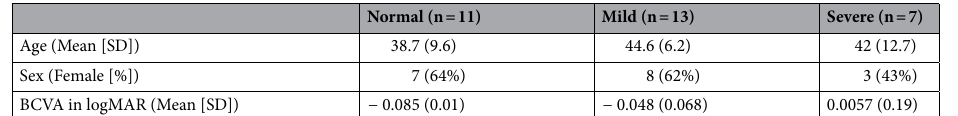
BCVA in logMAR (Mean Table 1. Demographic characteristics and BCVA across all participants. BCVA best-corrected visual acuity, logMAR logarithm of the minimum angle of resolution*, SD standard deviation. *a logMAR value of 0.1 is equivalent to a 20/25 Snellen chart, 0.0 is equivalent to 20/20, and − 0.1 is equivalent to 20/15.